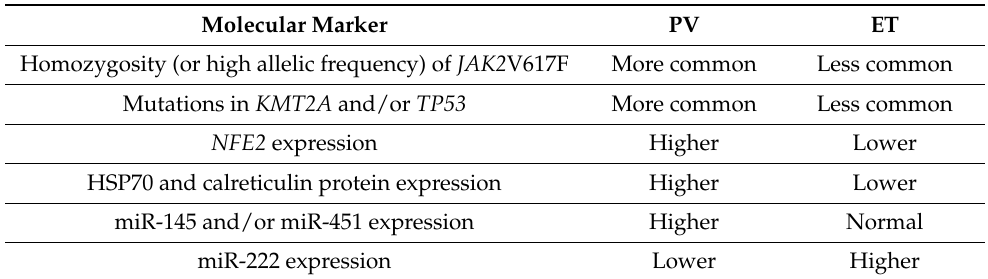
Table 1. Summary of genetic differences between PV and ET that can help differentiate the two MPNs. Molecular Marker PV ET Homozygosity (or high allelic frequency) of JAK2 V617F More common Less common Mutations in KMT2A and/or TP53 More common Less common NFE2 expression Higher Lower HSP70 and calreticulin protein expression Higher Lower miR-145 and/or miR-451 expression Higher Normal miR-222 expression Lower